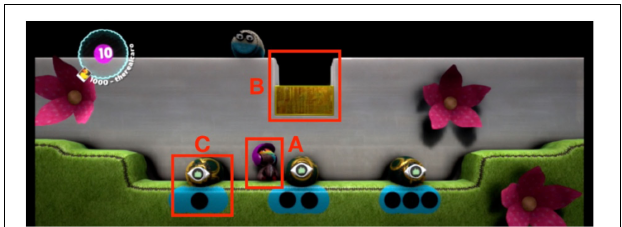
FIGURE 8 | The first puzzle in RA, with red annotations. (A) The player’s avatar; (B) the fraction (the golden block) that must be operated upon in order to fill the unit (the hole that the golden block is within); (C) the primary interaction method (a round button) and its attendant label (the single black dot). The player must determine which round button will perfectly fill the unit: activating (C) enacts “1 × 1/2,” which replicates (B) ; whereas activating the middle button enacts “2 × 1/2,” perfectly filling the (w)hole